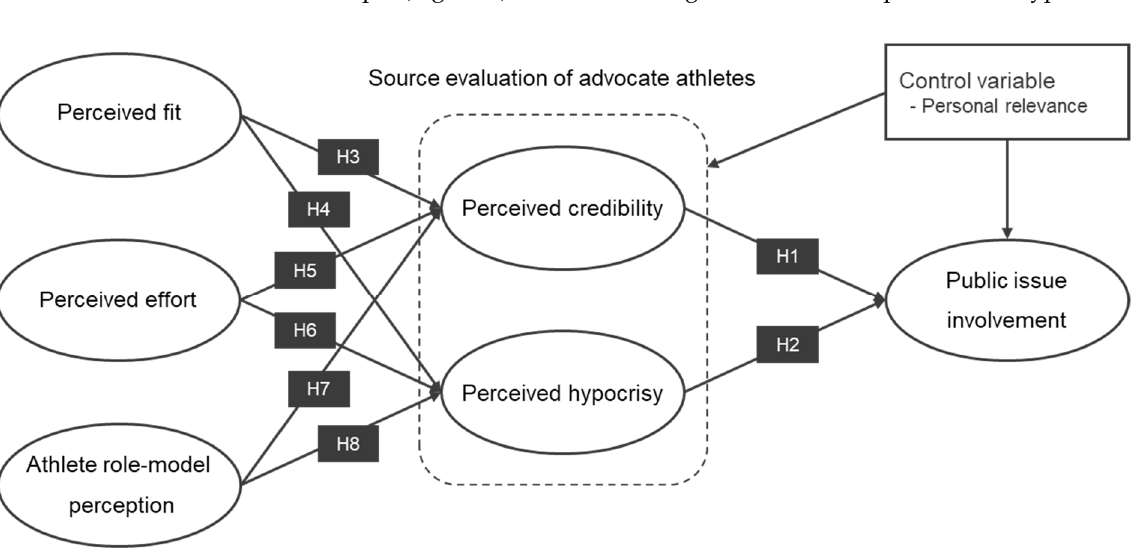
Figure 1. Hypothesized Model. H = hypothesis.